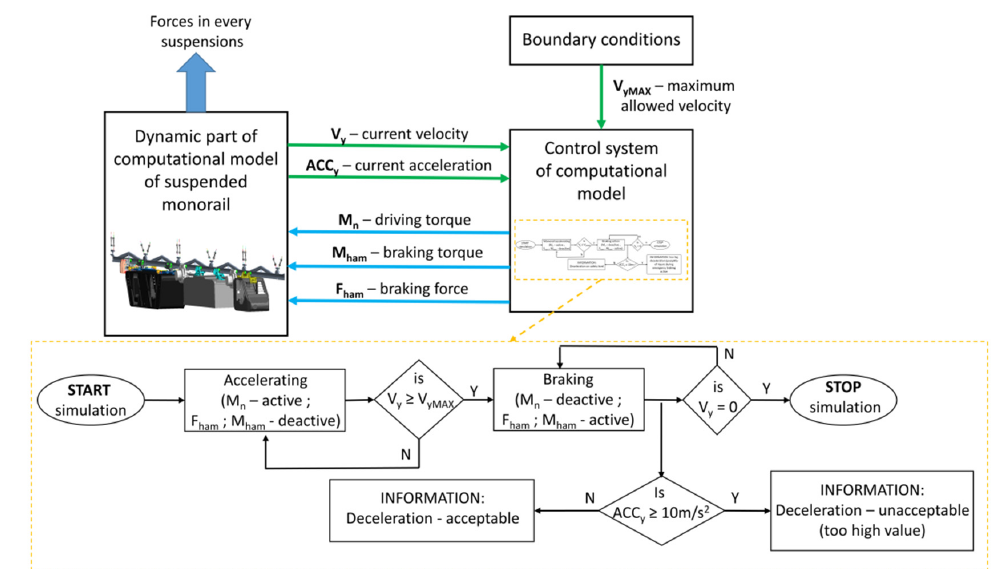
Figure 5. The structure and flow of signals in the computational model of the suspended monorail.